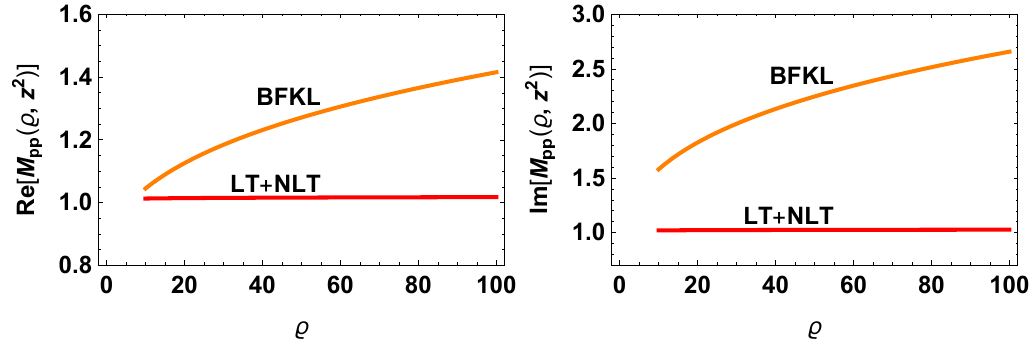
Figure 7 . Here we plot the real and imaginary part of the BFKL (5.10) and LT+NLT (6.12) both normalized to the LT, respectively; % variates from 10 to 100